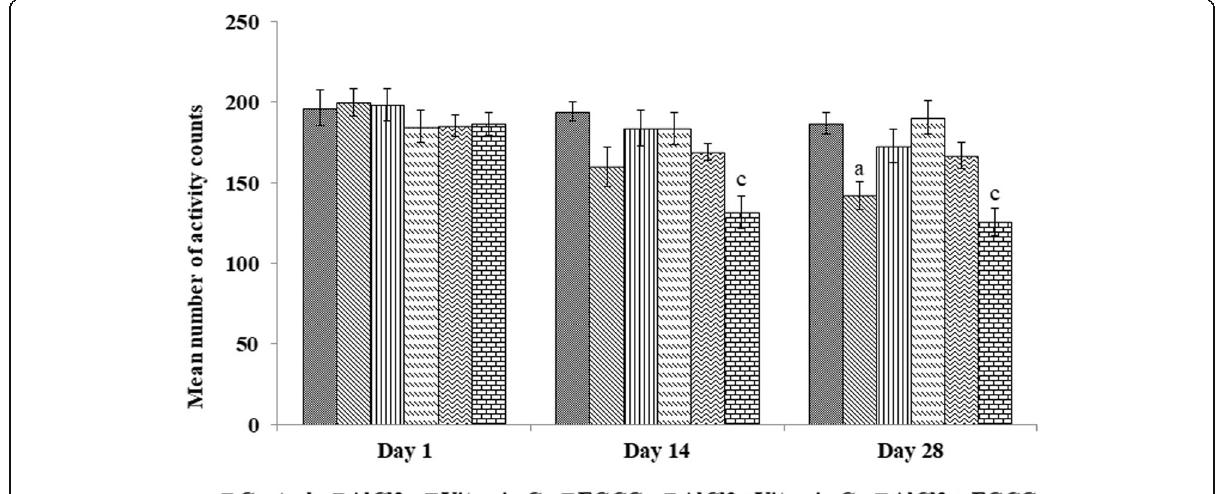
Fig. 2 Effect of EGCG on locomotor activity of the rats. Values are expressed as mean ± SEM ( n = 6). a P < 0.05 and c P < 0.001 compared with control (one-way ANOVA followed by Tukey ’ s post-hoc test)